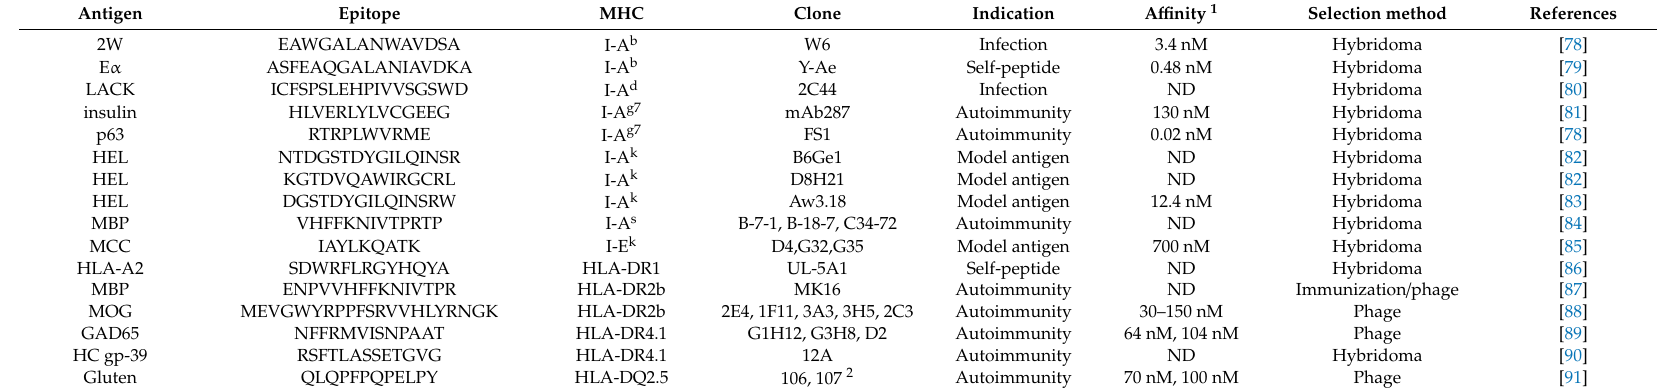
Table 2. T-cell receptor (TCR)-like monoclonal antibodies (mAbs) against peptide–major histocompatibility class II